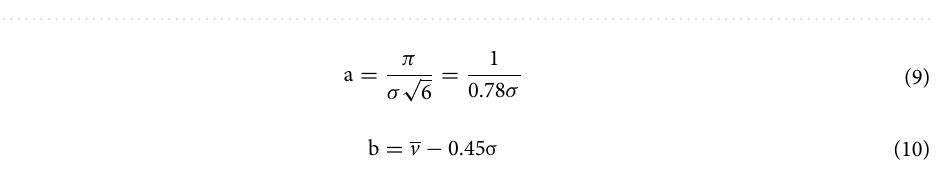
Figure 8. The variation of the wind